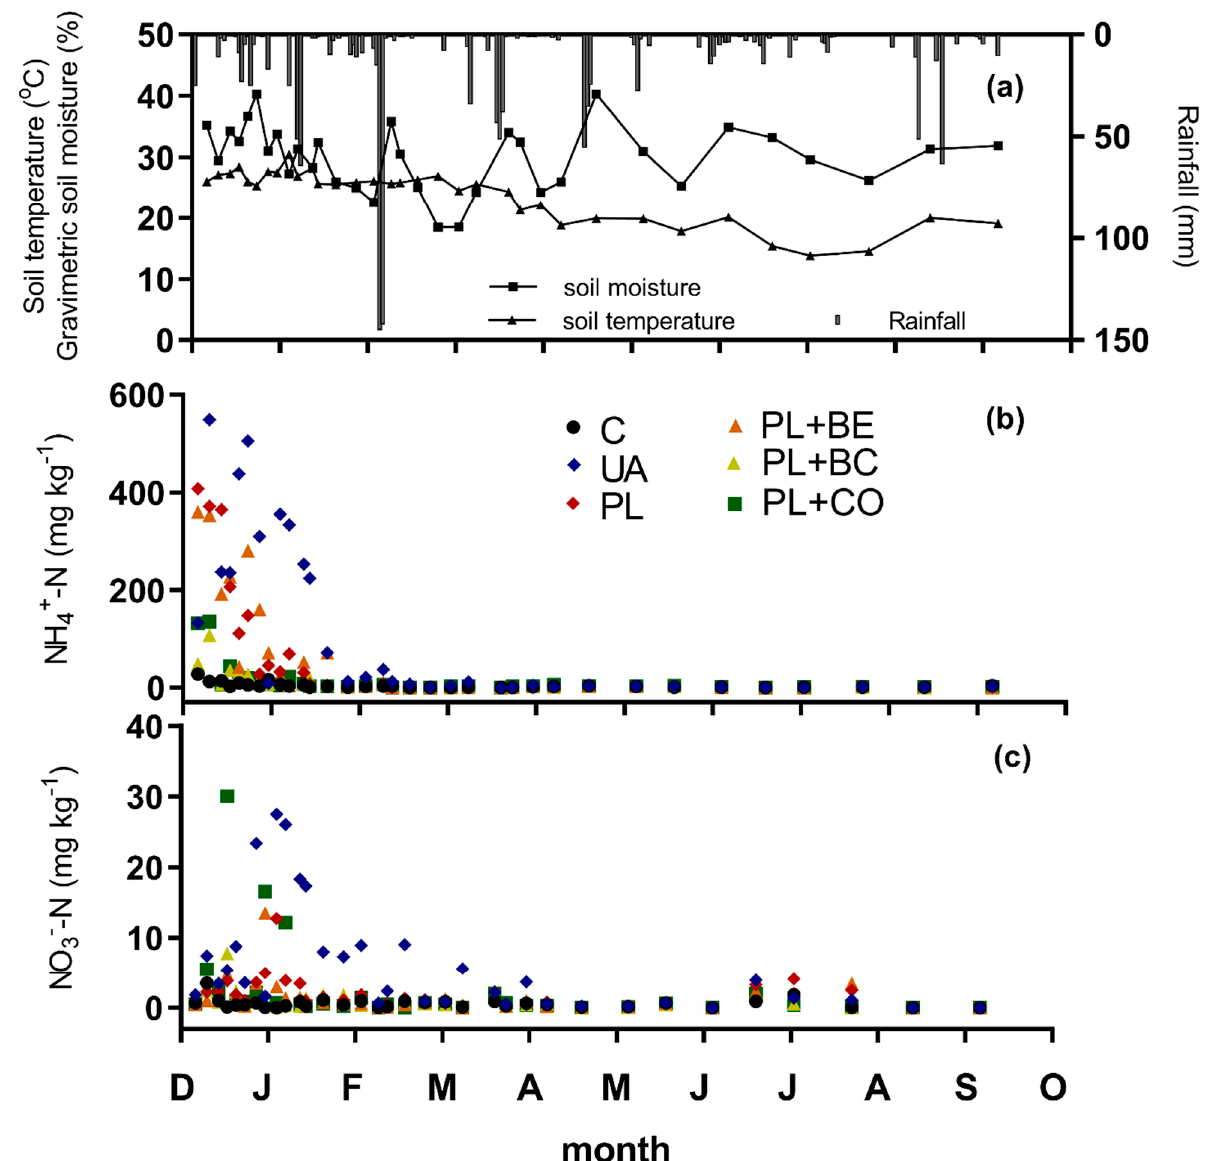
Figure 2. Environmental variables of the sugarcane field experiment over a 10-month crop cycle (December 2014 to September 2015, i.e., summer to spring). ( a ) Daily mean air temperatures ( ◦ C) and daily rainfall (mm), ( b ) mean soil NH 4 + -N concentrations (mg kg − 1 ; n = 3) in sugarcane rows, ( c ) mean soil NO 3 − -N concentrations (mg kg − 1 ; n = 3) in sugarcane rows. C control (no-N), UA urea (mineral fertiliser), PL poultry litter, PL + BE poultry litter +bentonite, PL + BC poultry litter + biochar, PL + CO poultry litter + compost. Error bars in ( b , c ) were omitted for legibility with high variability within treat- ments.